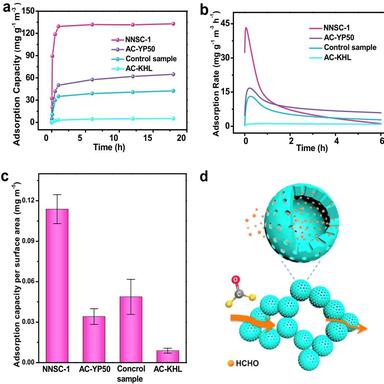
(a) Adsorption capacities and (b) adsorption rates of formaldehyde for NNSC-1, AC-YP50, AC-KHL and control sample. (c) Adsorption capacities per surface area of NNSC-1, AC-YP50, AC-KHL and control sample within 18 h. Error bars represent the standard deviation of triplicate experiments. (d) Scheme of the adsorbing formaldehyde process of NNSC.